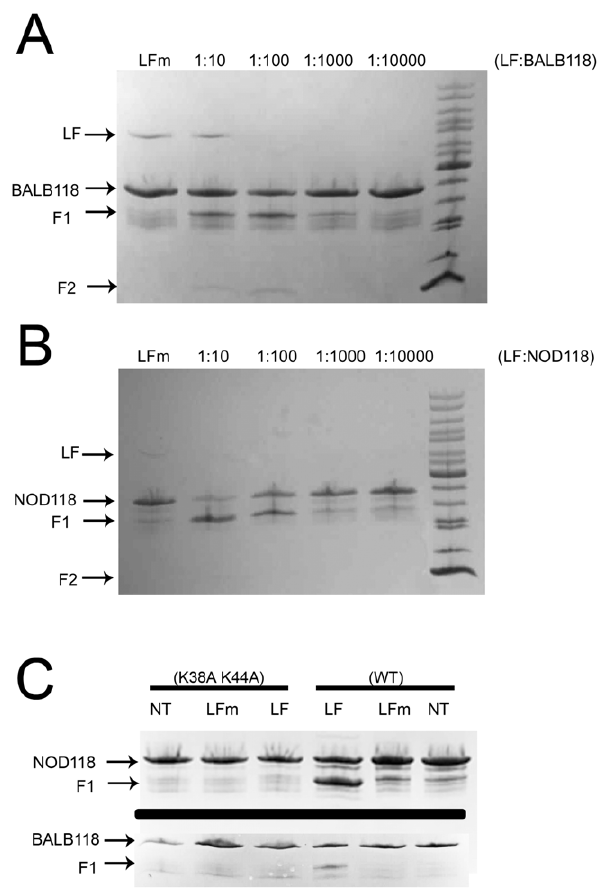
Figure 3. Cleavage of mouse BALB118 and NOD118 Nlrp1 fusion proteins by LF. (A, B) In vitro cleavage of N-terminally 6His- GST-tagged aa 3-118 of Nlrp1b proteins. Purified proteins (0.53 mg/ml or 0.94 mg/ml, in A and B, respectively) were treated with the indicated molar ratios of LF, or with a 1:10 molar ratio of the mutant LF E687C (LFm), for 4 h prior to SDS gel electrophoresis and Coomasie staining. F1 and F2 refer to two fragments generated following LF treatment. (C) GST-tagged or double alanine mutant variants (0.44-0.66 mg/ml) were treated with 33 m g/ml LF or LFm for 4 h prior to SDS gel electrophoresis and Coomassie staining.